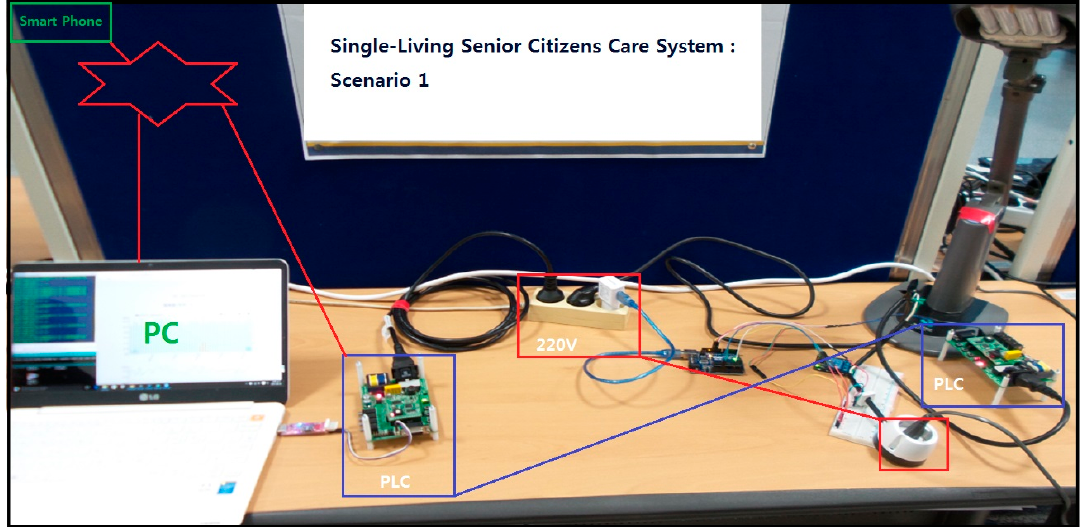
Figure 5. Scenario 1 (220 V Two PLC).